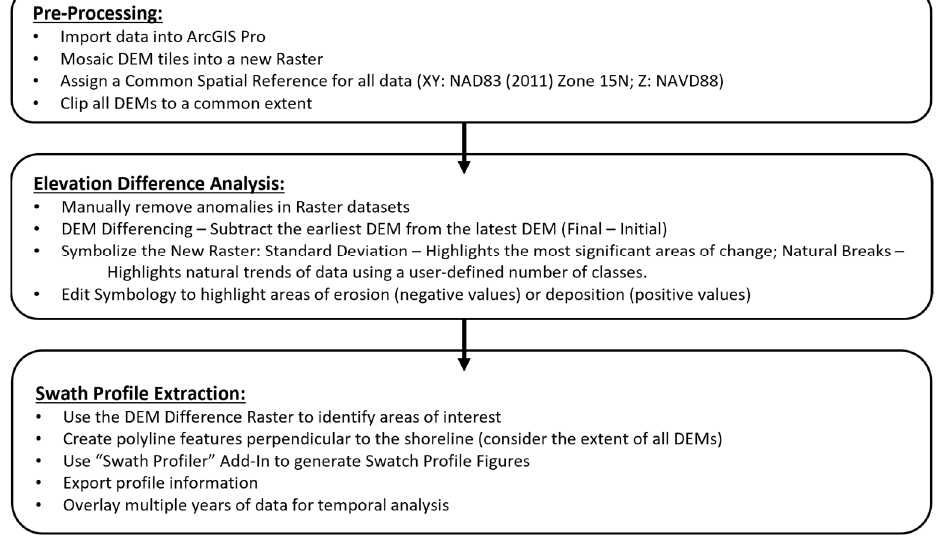
Figure 6. Workflow diagram summarizing the key steps taken to process data for the change analysis.